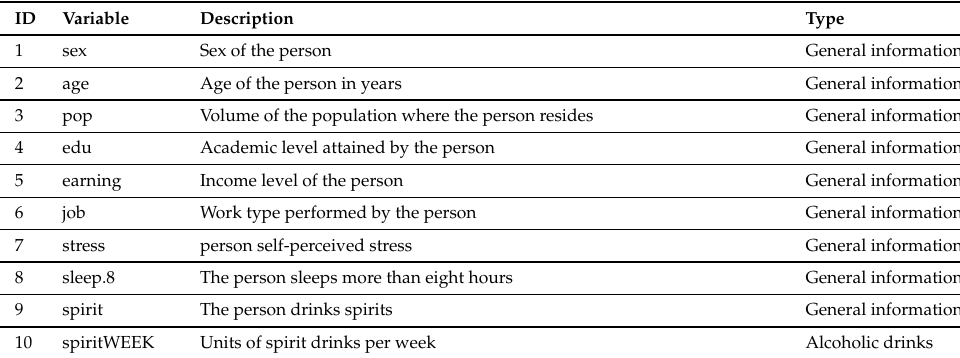
Table A1. Representation of project